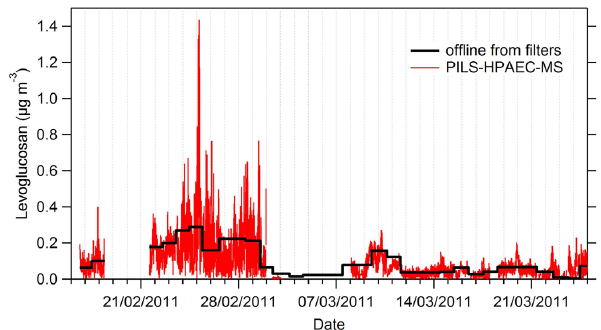
Fig. 4. Time series of levoglucosan measured online with the PILS– HPAEC–MS and determined offline from the filter samples with the HPAEC–MS. The PILS–HPAEC–MS measured with a time resolu- tion of 8min, whereas the sampling duration for the filters varied from 18 to